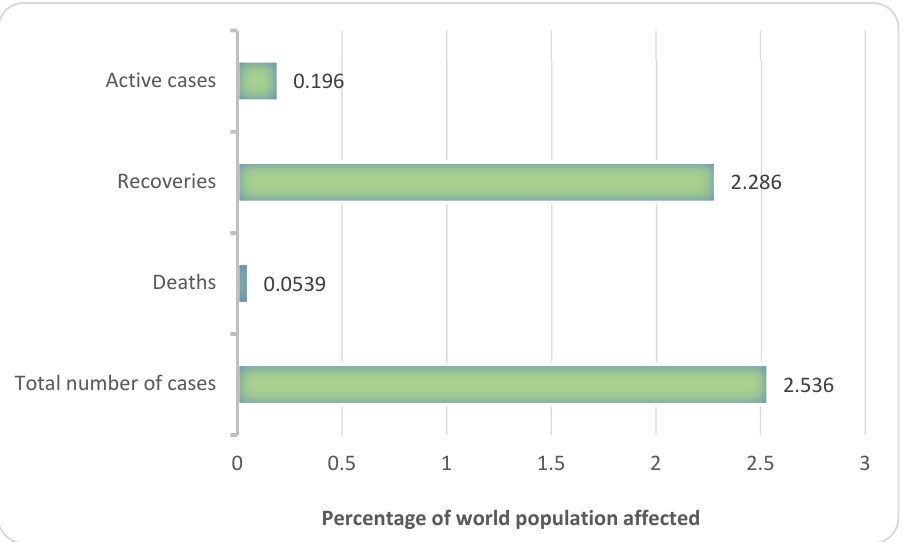
Figure 1. Prevalence of COVID-19 in the population (Source: https://covid19.who.int/ accessed on 10 September 2021). The figure indicates the total number of COVID-19 infections worldwide with the percentage of active cases, recoveries and deaths recorded in the population).